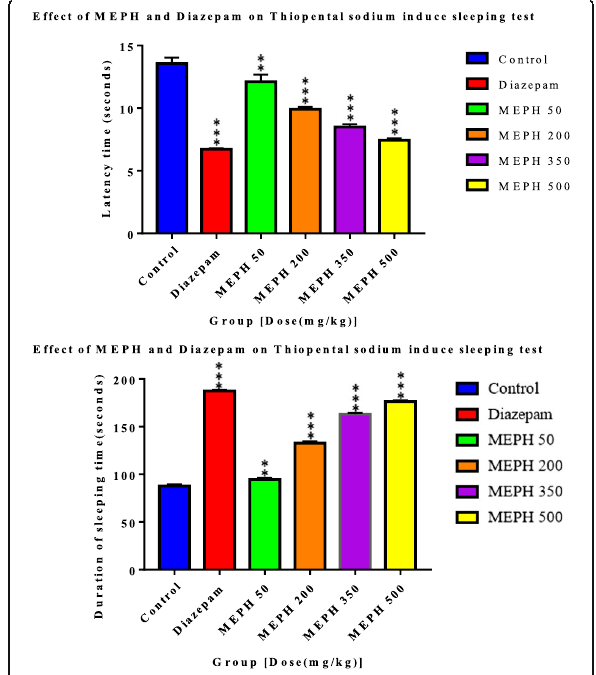
Fig. 4 The effect of MEPH on the Thiopental sodium induce sleeping test (Latency time and sleeping time) in mice